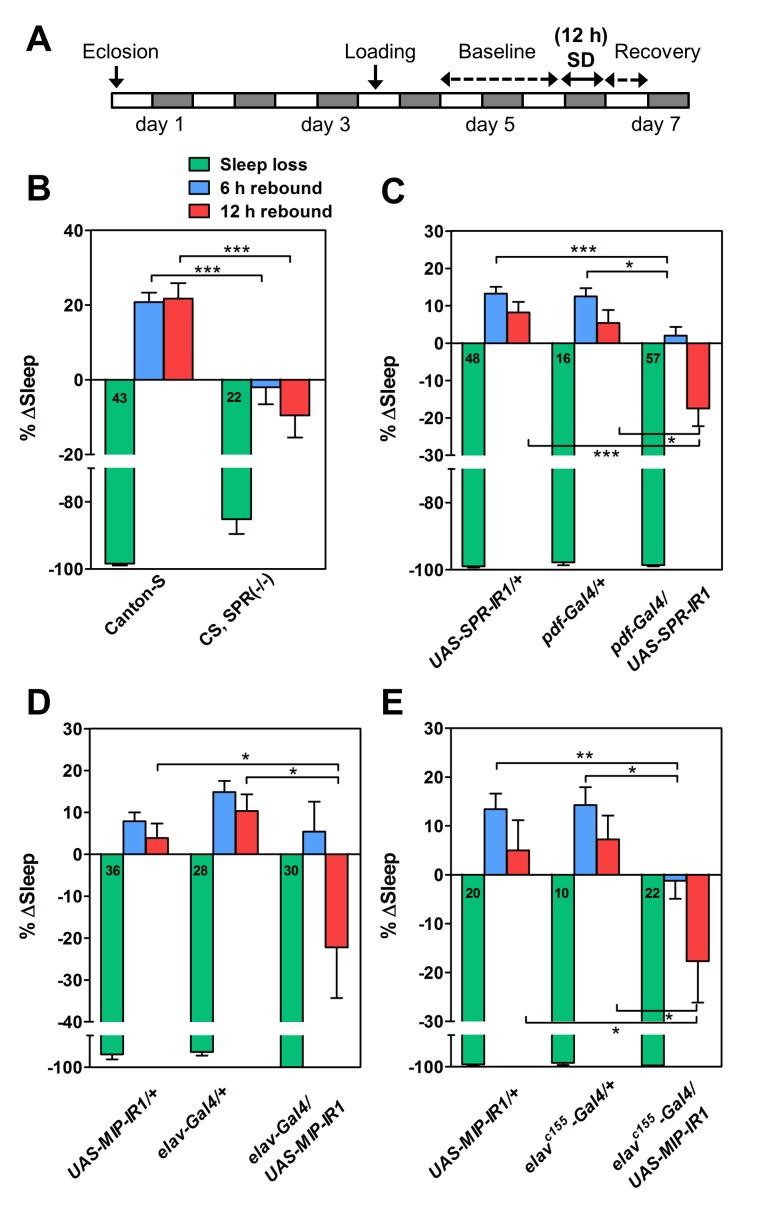
MIP and SPR are required for maintaining sleep homeostasis.(A) Experimental protocol used to quantify sleep homeostasis. (B–E) The percentage change in sleep (% Δsleep) after 12 h of mechanical sleep deprivation (green), 6 h (blue), and 12 h of sleep recovery (red) in females of indicated genotypes, measured the next morning. Number in bars indicates n. Data are shown as means ± SEM. *, p<0.05, **, p<0.01 ***, p<0.001 for the comparison to each controls by Student's t test.